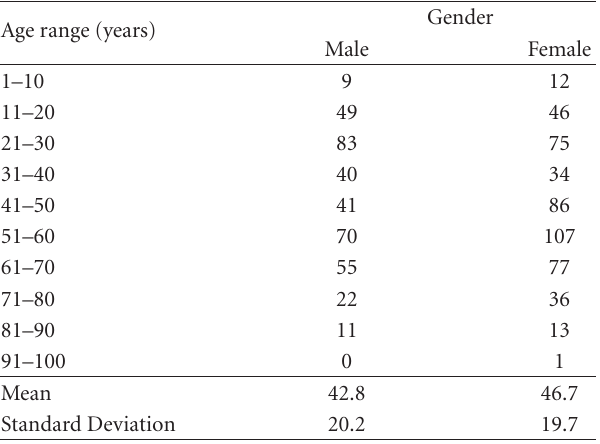
Table 1: Age distribution of the male and female population.